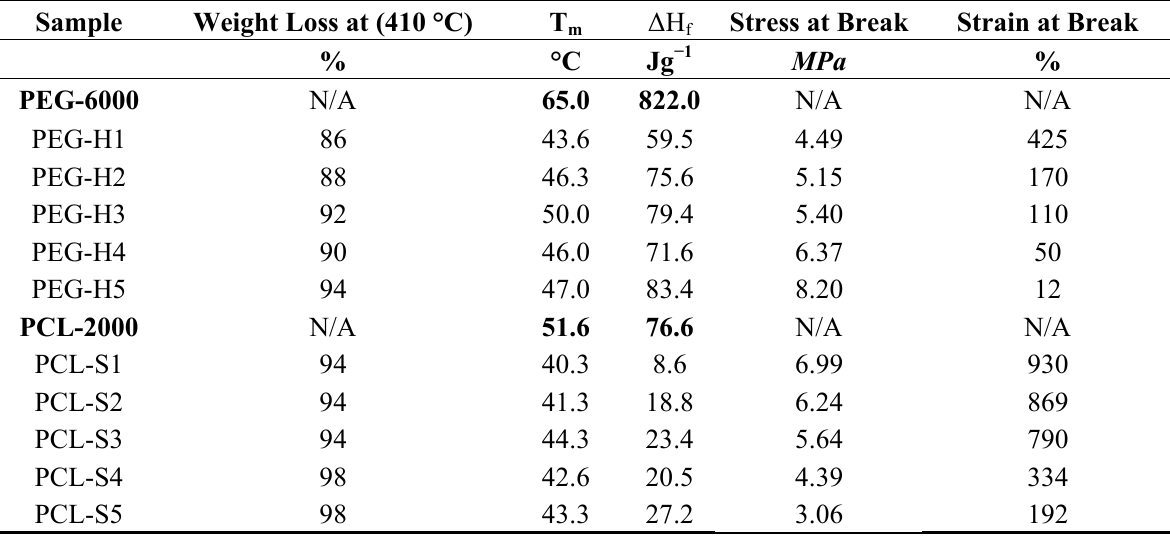
and heat of fusion of PEG and m